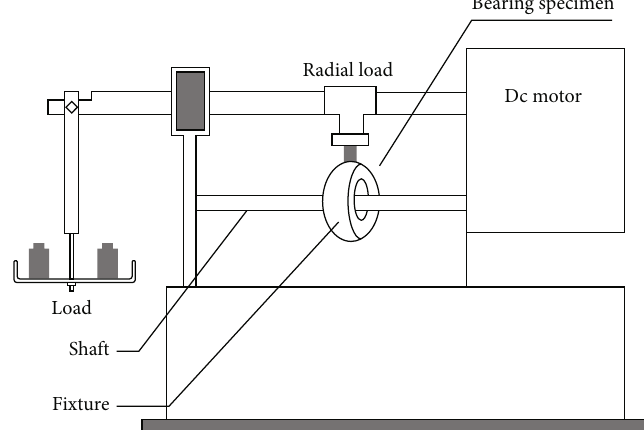
Figure 5: Bearing test rig.